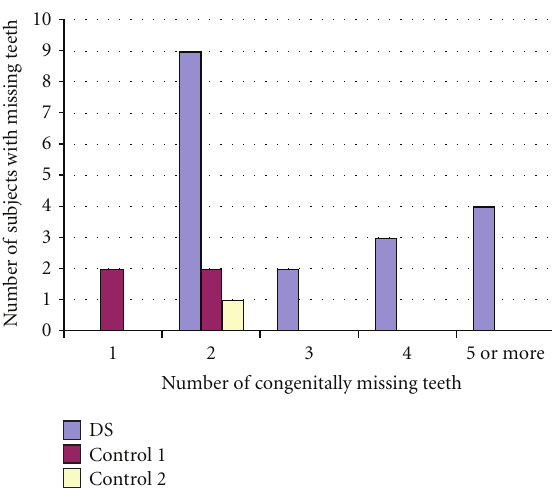
Figure 4: Distribution of subjects with multiple missing teeth.